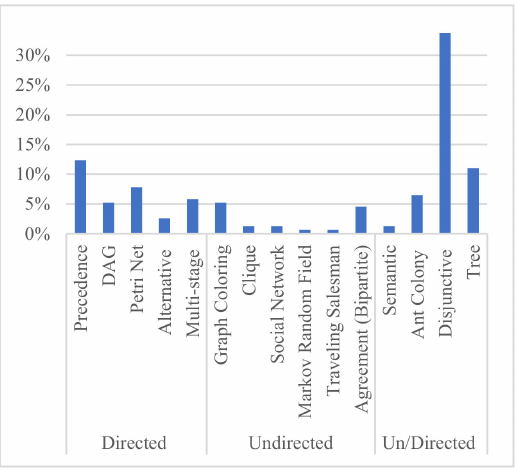
Figure 23. Percentage of different types of graph-based models in the dataset.